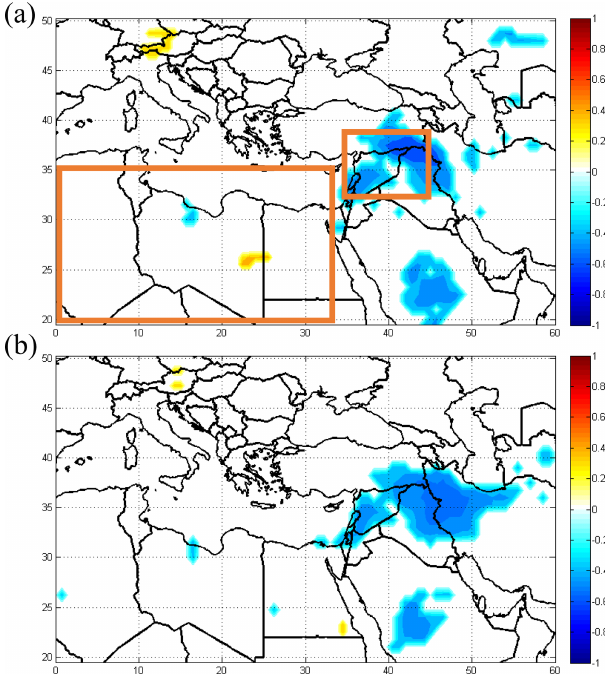
Figure 9. Individual summer means of background levels of Ca 2 + , Mg 2 + and of the [Mg 2 + red . ] / [Ca 2 + red . ] mass ratio along the El- brus ice cores.